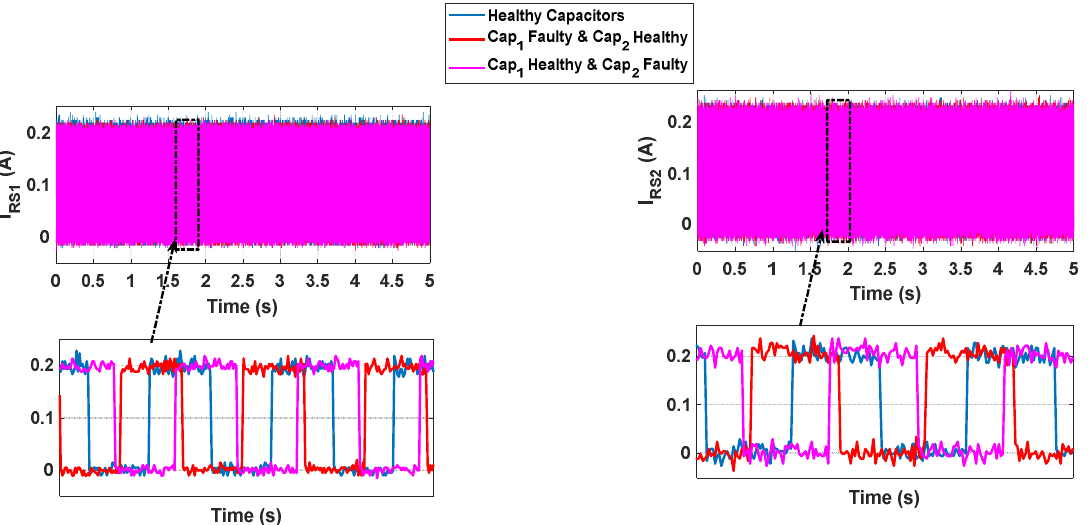
Figure 8. LED fixtures’ instantaneous currents I Rs1 and I Rs2 , considering both states (healthy and faulty).